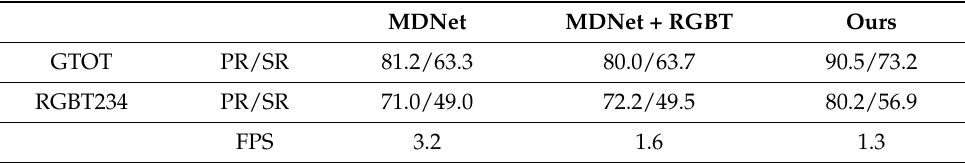
Table 3. PR/SR score ( % ) and runtime of our framework against baseline MDNet+RGBT on GTOT and RGBT234